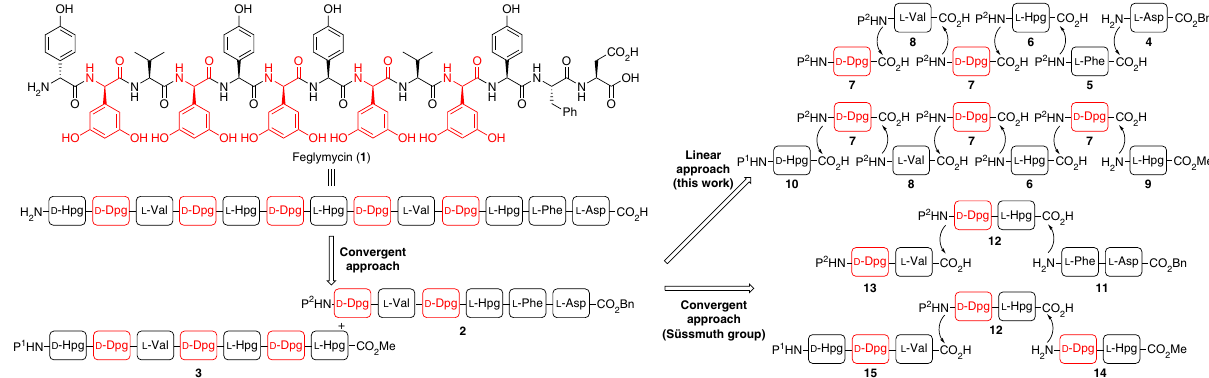
Figure 1 | Synthetic strategy for feglymycin (1). Our linear synthetic approach and Su¨ssmuth’s convergent synthetic approaches. Su¨ssmuth concluded that the linear approach for oligopeptides 2 and 3 containing D -Dpgs was not possible.